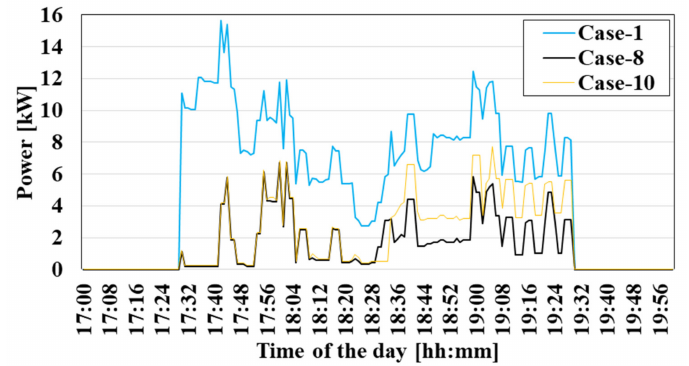
Figure 13. Power curtailment in Case-1, Case-8 and Case-10. The total power consumption of the electrolyzer during the day in Case-1 and Case-2 is given in Figure 14. As can be seen from the behavior of the common hydrogen tank and FCEVs in Case-1 and Case-2, the electrolyzer is being further evaluated in order to minimize the total cost. In Case-2, on the other hand, there is only the aim of curtailment minimization. The electrolyzer consumes 651.86 kWh in Case-1 and 84.11 kWh in